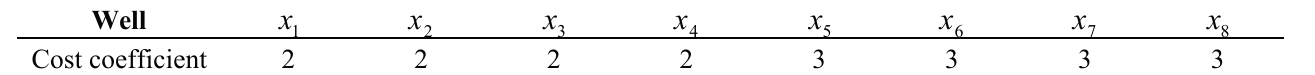
Table 5. Water cost coefficients ($·d·m -3 ).